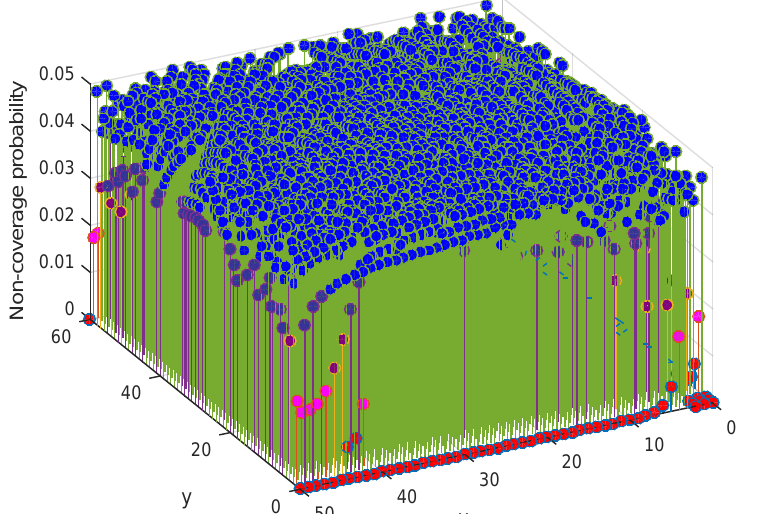
Figure 13. Non-CP for CI ER,5% (0..60, 0..50, 60,